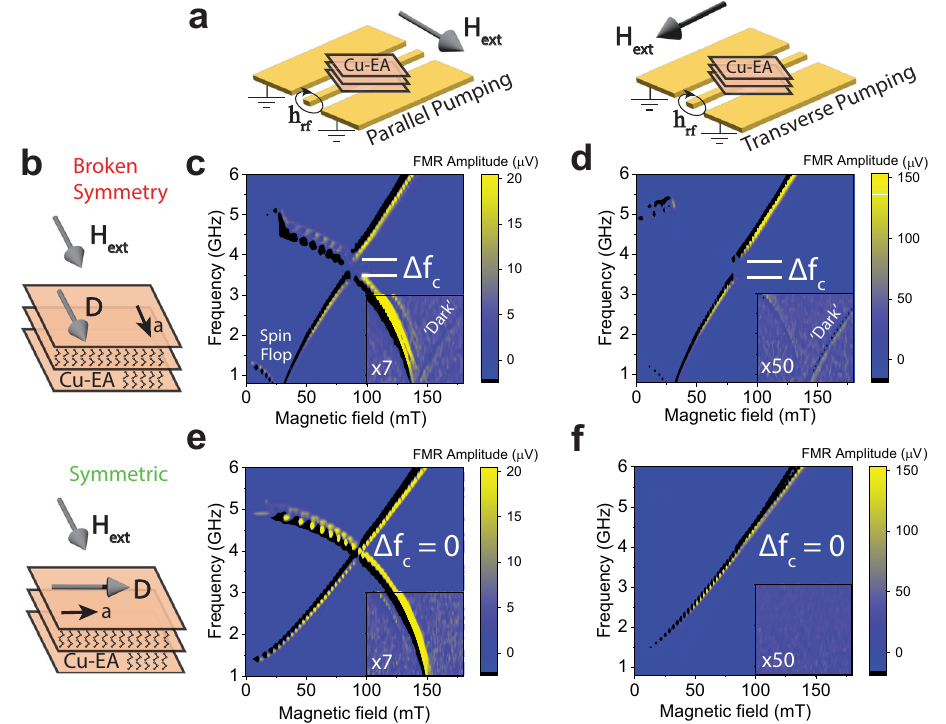
Fig. 2 | Antiferromagnetic resonance in Cu-EA single crystals with a strong magnon – magnoncoupling induced by the DMI. a Schematic illustrations of the parallelandtransversepumpinggeometriesforselectivelyexcitingtheopticaland acoustic modes when the external magnetic fi eld is applied parallel and perpen- dicular to the microwave RF fi eld, h rf . b Schematic illustrations of the broken symmetry ( H ext k D ) and symmetric ( H ext ? D ) pumping con fi gurations when the